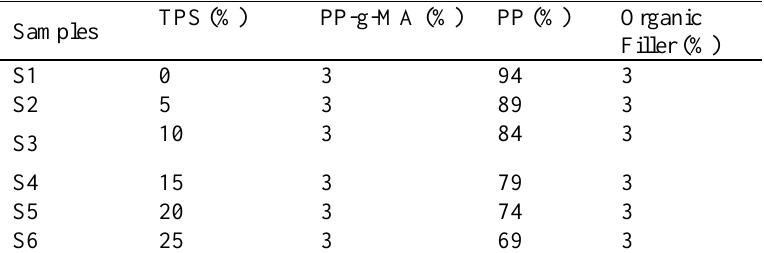
Table 1. Concentration in % of the different constituents of the 6 composites (S1-S6) made of